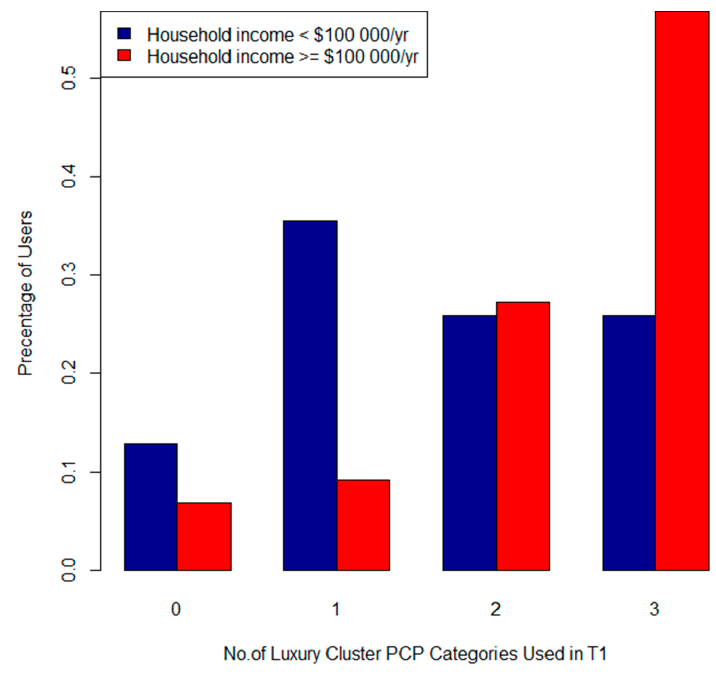
Figure 9. Total number of Daily PCPs (Cluster 2) used per participant by income category in T1.